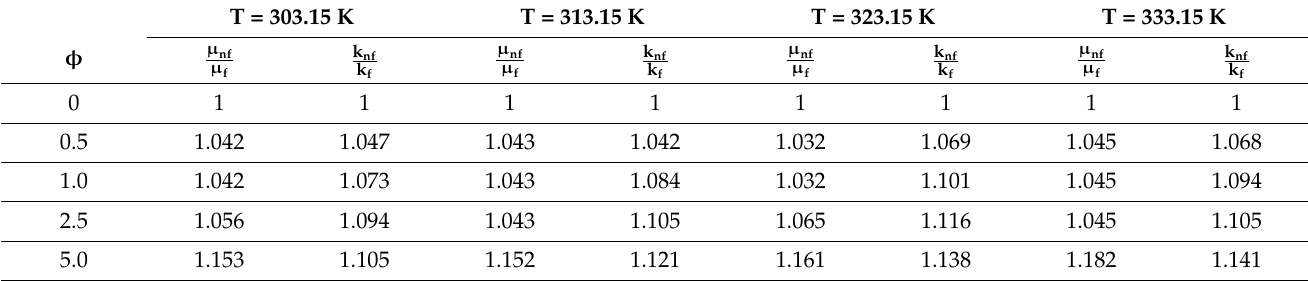
Table 2. Nanoparticle concentration and temperature variation on both thermal conductivity and